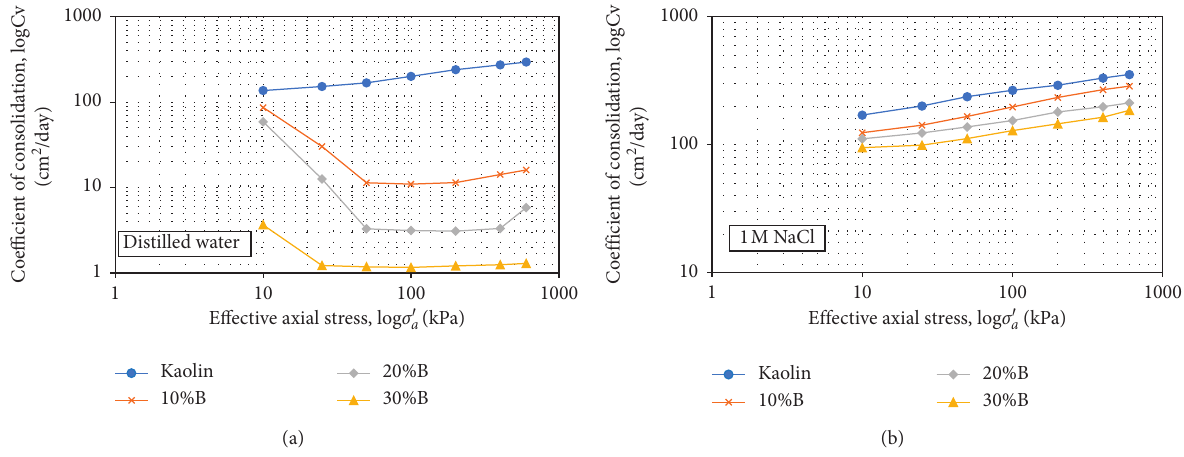
Figure 8: Variation of C v with effective axial stress. (a) Distilled water; (b) 1M NaCl.